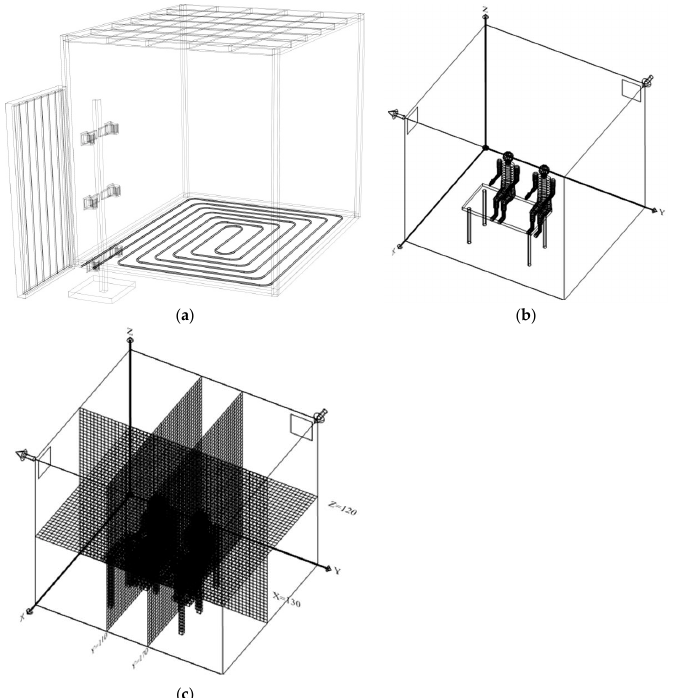
Figure 1. ( a ) Chamber, water ducts and collector scheme used in the building thermal response (BTR) numerical model; ( b ) occupants, interior bodies and chamber schemes used in the human thermal comfort (HTC) numerical model; ( c ) occupants, interior bodies and plans located at Y = 110 cm (Y22), Y = 170 cm (Y34), X = 130 cm (X23) and Z = 120 cm (Z23), used by the CFD numerical model in the